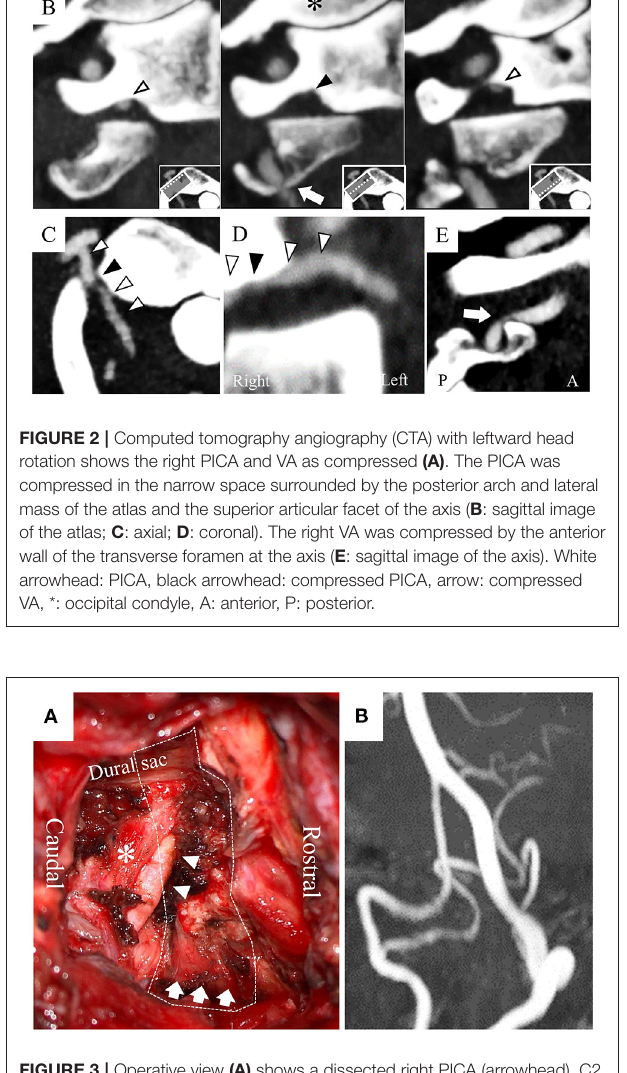
FIGURE 3 | Operative view (A) shows a dissected right PICA (arrowhead), C2 nerve root (*), and decompressed right VA (arrow) after resecting part of the atlas (dotted line: resected atlas). Postoperative MRA at 60 ◦ leftward head rotation (B) shows no compression of the right PICA and